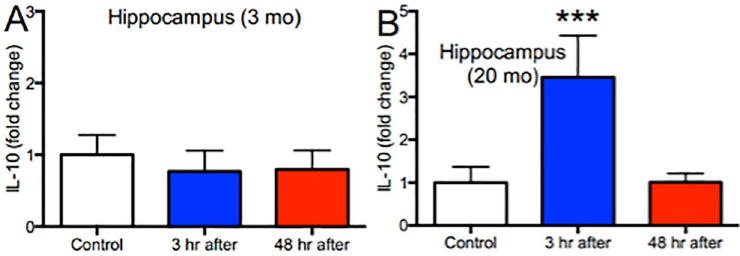
Fig 4. Isoflurane increases IL-10 expression in the hippocampus of aged but not young mice. Mice were anesthetized as described and IL-10 measured in the hippocampus by RT-PCR. Isoflurane had no effect in either region in young mice (A) but increased IL-10 nearly 4-fold in old mice. Data expressed as mean ± SD for N = 6 animals per treatment condition. ��� p < 0.001 relative to age-matched controls by 1-way ANOVA with Dunnett’s test for multiple comparisons.